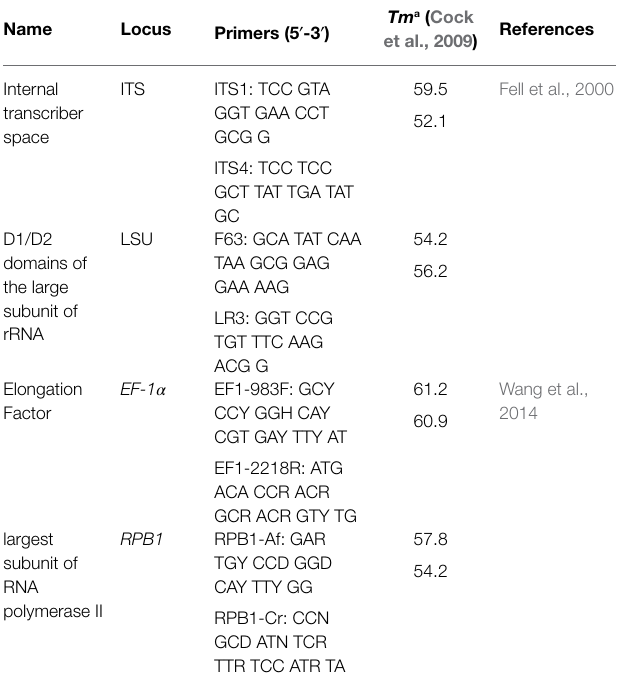
TABLE 2 | Primers of ITS, LSU, EF-1 α , and RPB1 used in this